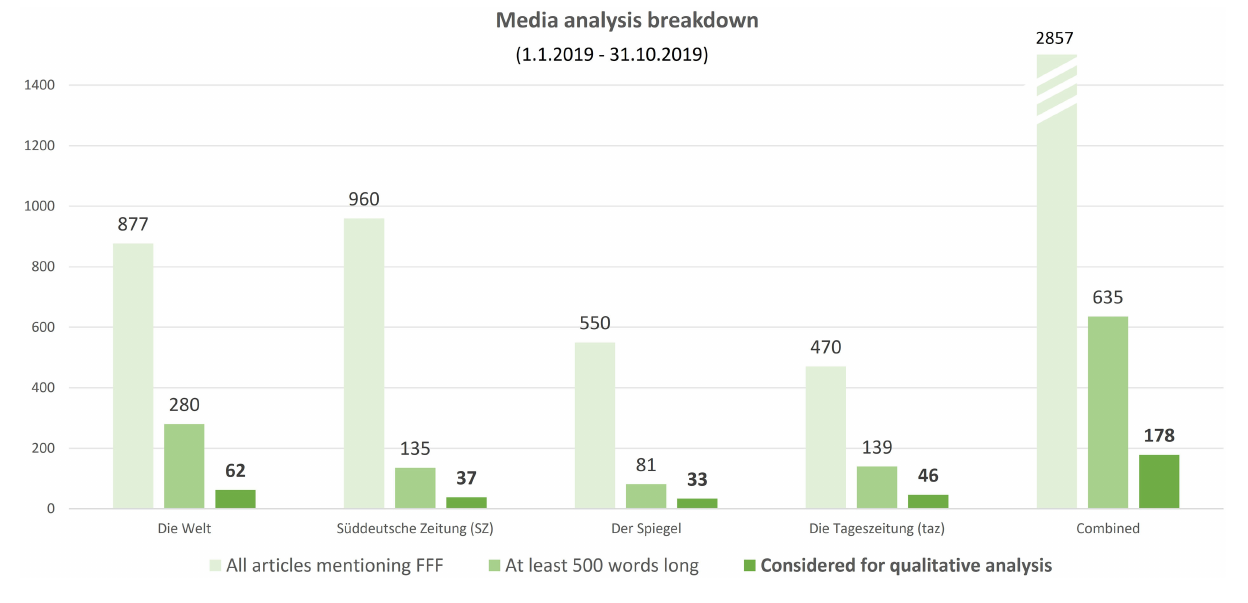
Frontiers in Communication |